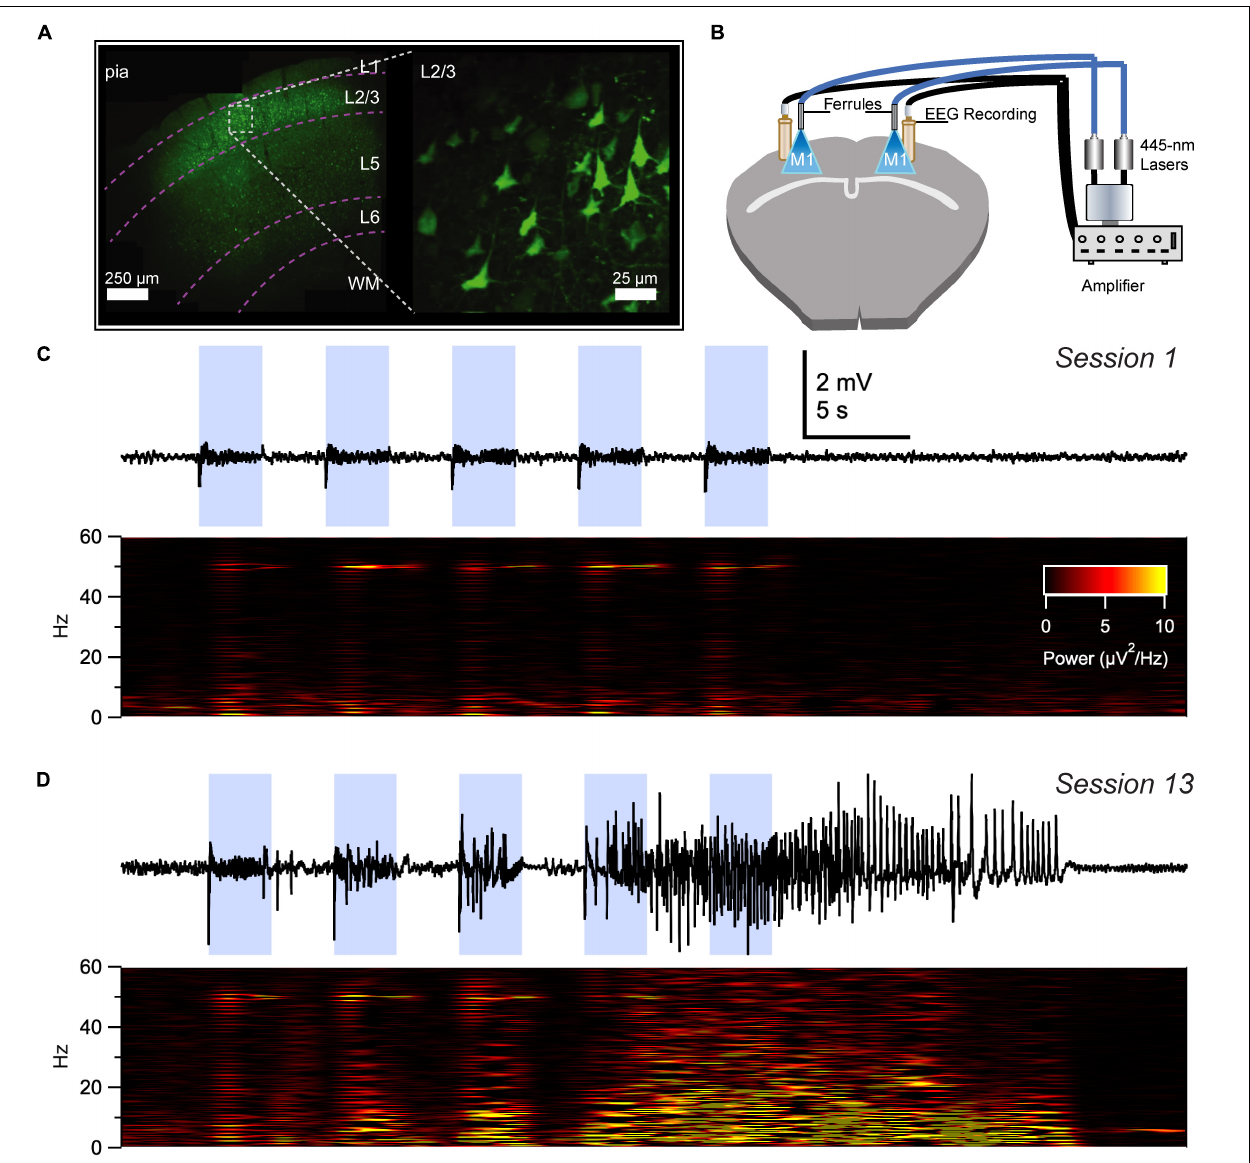
FIGURE 2 | Optokindling via simultaneous EEG recording and ChR2 stimulation in awake behaving animals. (A) Coronal M1 section immunostained for EYFP indicated ChR2 expression in layer 2/3 (L2/3), 5, and 6, though predominantly in L2/3. Inset shows close-up of L2/3 ChR2-expressing PCs. (B) To simultaneously activate ChR2 and acquire EEG, ferrules and recording screws were implanted bilaterally above M1, without penetrating the cortex. Fiber optic cables were air-coupled to 445-nm lasers. EEG signals were processed by an extracellular amplifier, but not pre-amplified. A computer (not shown) TTL-gated the lasers and digitized amplified EEG signals. (C) Sample EEG trace illustrating that M1 optokindling did not elicit seizures in stimulation session 1 of 25 (Top). Spectrogram shows direct light-driven responses in the 50-Hz band but no seizures (Bottom). (D) M1 optokindling in session 13 elicited a prominent seizure in this sample EEG sweep (Top). Spectrogram reveals both light-driven responses in the 50-Hz band as well as increased power in low-frequency bands (Bottom). Reproduced and modified from Figure 1 in Cela et al. (2019), with